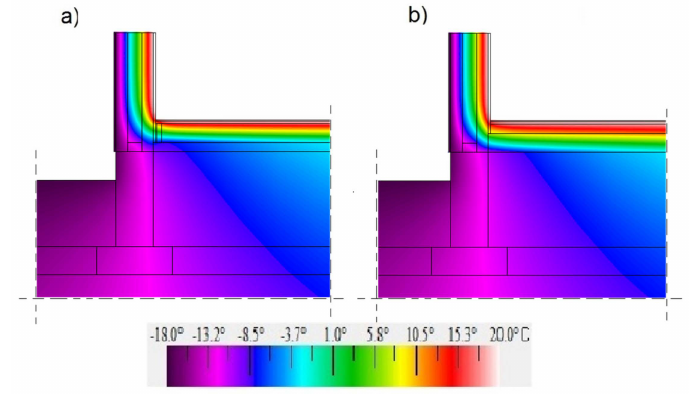
Figure 12. Temperature distribution in the ground junction with the “400c” wall filled with a hemp–lime composite ( λ = 0.080 W / (m · K)) and with the floor on the ground at the adopted level “ − 100”: ( a ) floor on joists; ( b ) self-supporting floor.